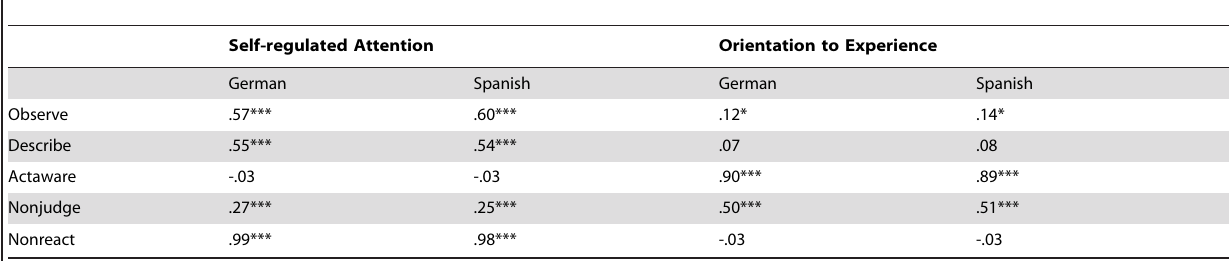
Table 6. Facet Factor Loadings in the Two-Factor Higher-Order Multigroup ESEM Analysis.